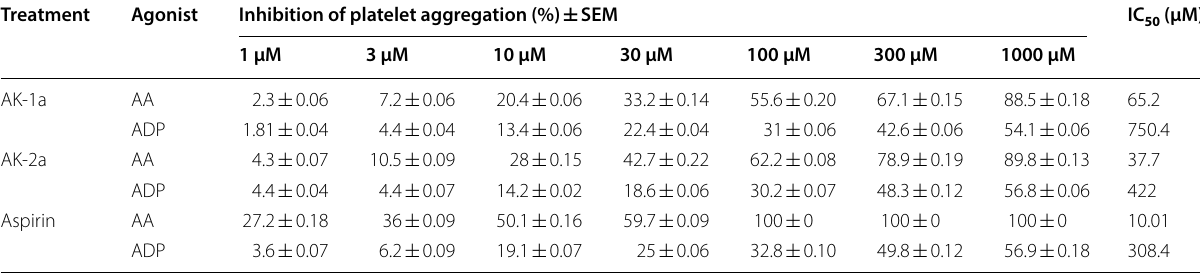
Table 4 Inhibitory effect of